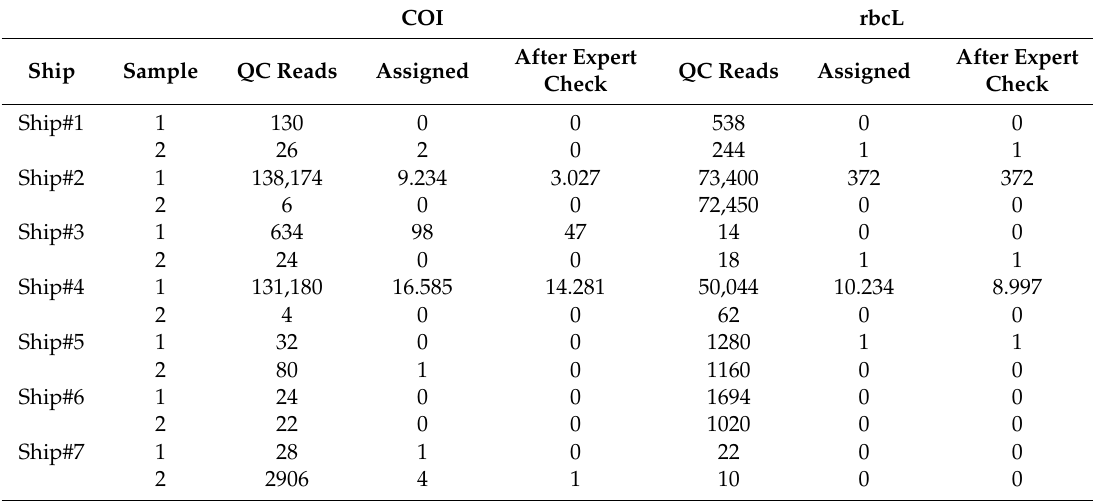
Table 2. Next-generation sequencing (NGS) results obtained from the ballast water samples analysed, presented as the number of reads obtained per sample, assigned taxonomically from QIIME pipeline, and from marine taxa (after expert check). QC: Quality control. COI and rbcL are cytochrome oxidase I and ribulose-1,5-bisphosphate carboxylase / oxygenase gene metabarcodes,